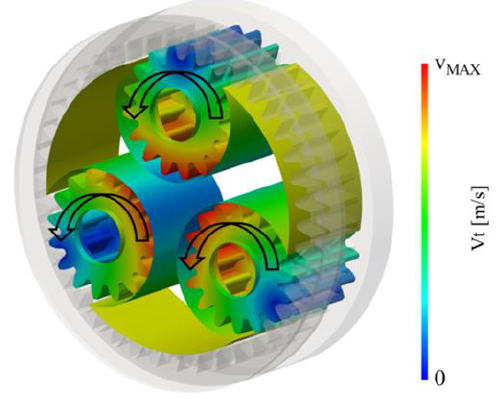
Figure 5. Velocity contour plot of the system in the central